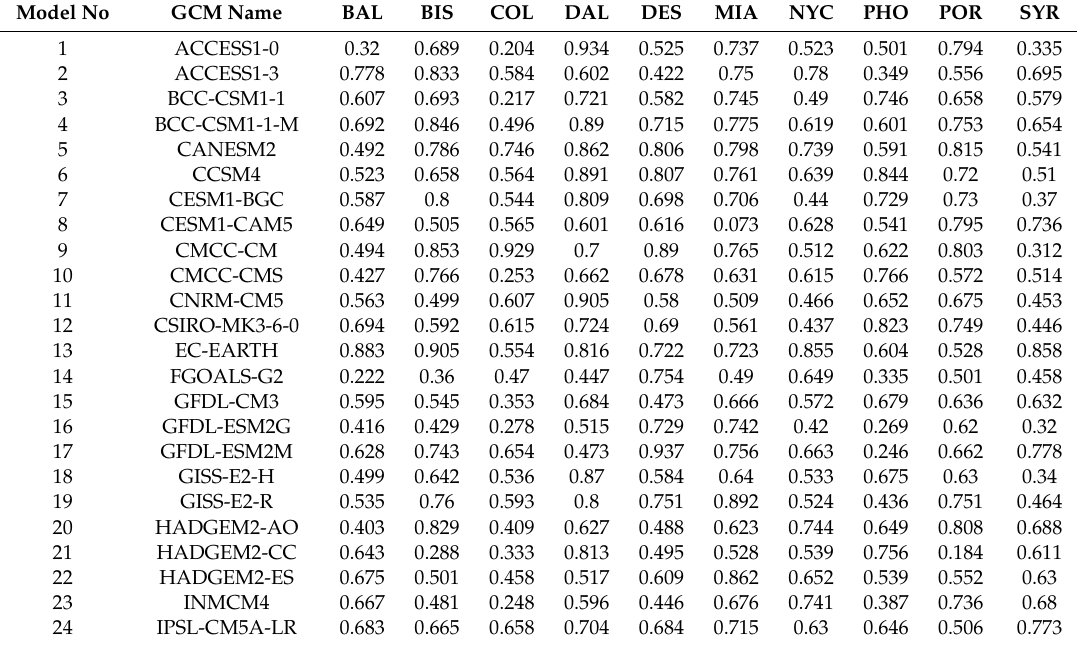
Table A13. Relative Closeness to the Ideal Solution for each